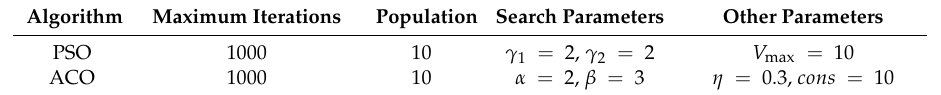
Table 5. Parameter settings for PSO and ACO. Algorithm Maximum Iterations Population Search Parameters Other Parameters